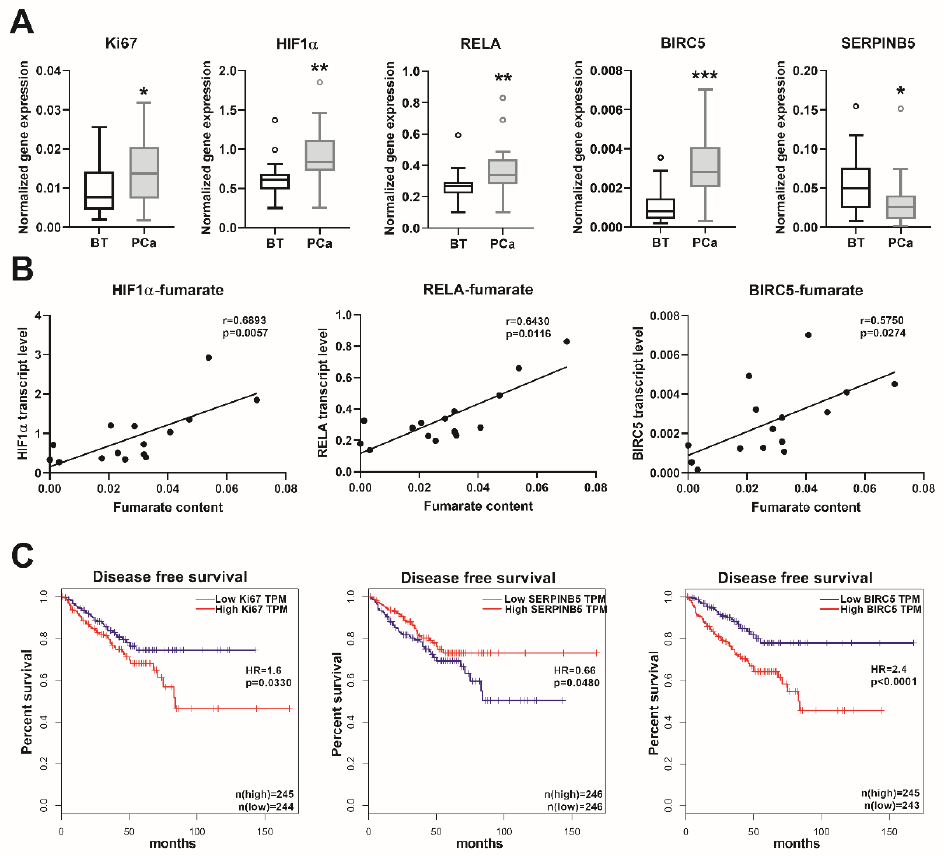
Figure 5. Transcript levels of the oncogenic genes and patients´ survival. ( A ) Transcript levels of the indicated genes were measured using real-time PCR in extended prostate cancer (PCa) and benign prostatic tissue (BT) cohorts. Data are shown as Tukey boxplots, n: 21–23. Statistical significance was calculated using Mann–Whitney U tests and was considered as p < 0.05. * p < 0.05, ** p < 0.01, *** p < 0.001. ( B ) The correlation between the fumarate content and the expression of the indicated genes are shown as linear regression (black line). For this analysis, we used those prostate samples from which both fumarate and real-time PCR data were available. Correlation was determined using Spearman’s correlation (see r and p values) and statistical significance was considered as p < 0.05. ( C ) Disease-free survival rates (Kaplan-Meier curves) of patients with low and high expression for the indicated genes from the human cancer genome atlas (TCGA) (https: // www.cancer.gov / tcga). Data were stratified according to the median values (low and high expression groups) and p -values were calculated with the log-rank test. HR: hazard ratio, HIF1 α : hypoxia-inducible factor 1-subunit alpha, RELA: NF κ B subunit RELA proto-oncogene / p65, BIRC5: baculoviral IAP repeat containing 5 / survivin, SERPINB5: serpin family B member 5 / maspin, and TPM: transcripts per kilobase